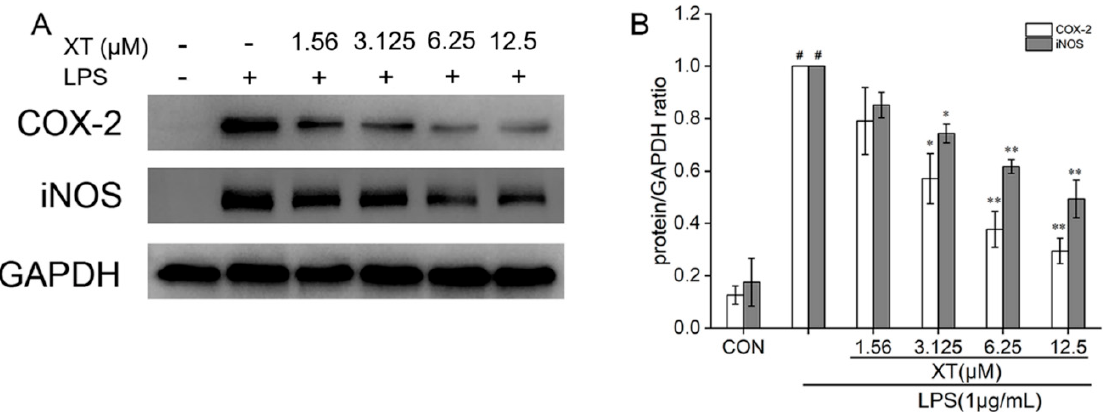
Figure 6. Effect s of xanthatin on iNOS and COX − 2 protein expression in RAW 264.7 cells. When cells were pre − treated with xanthatin and then activated by LPS, we clarified the protein of iNOS and COX − 2 ( A ) by Western blotting. The relative expression grey value of each protein band is shown ( B ). GAPDH was considered as an internal reference. Data is shown as means ± SDs (n = 3). #: significantly different compared to the control (CON) group, *: p < 0.05, **: p < 0.01, as compared to the LPS − induced group.